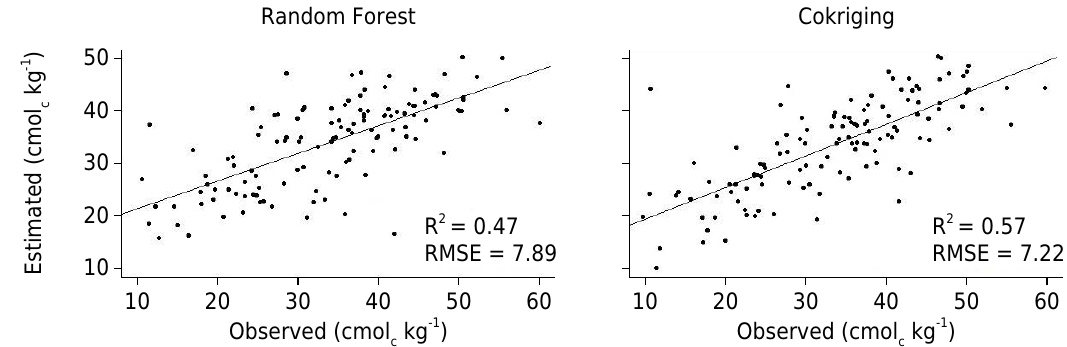
Figure 4. Plot of observed and estimated values, coefficient of determination (R 2 ), and the root mean square error (RMSE) obtained from models and validation samples.